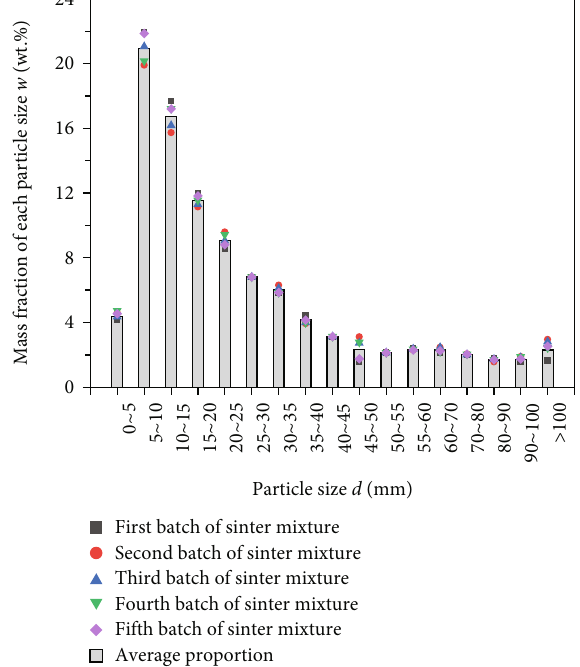
Figure 2: The original particle size distribution of sinter